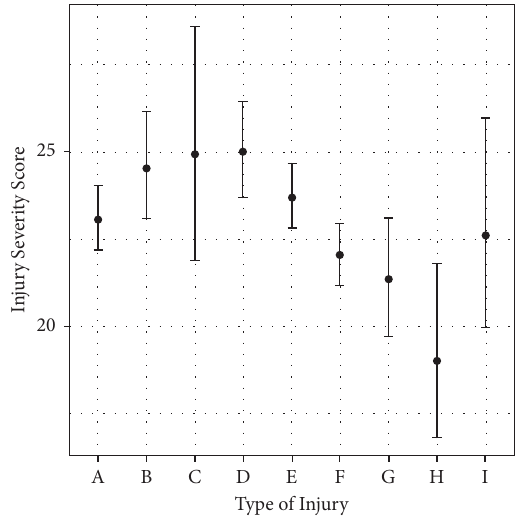
Figure 4: Mean ( ± standard deviation) injury severity score by trauma mechanism (A, car accident; B, motorcycle accident; C, bicycle accident; D, pedestrian accident; E, fall; F, slipping and rolling down; G, crush injury; H, assault; I,